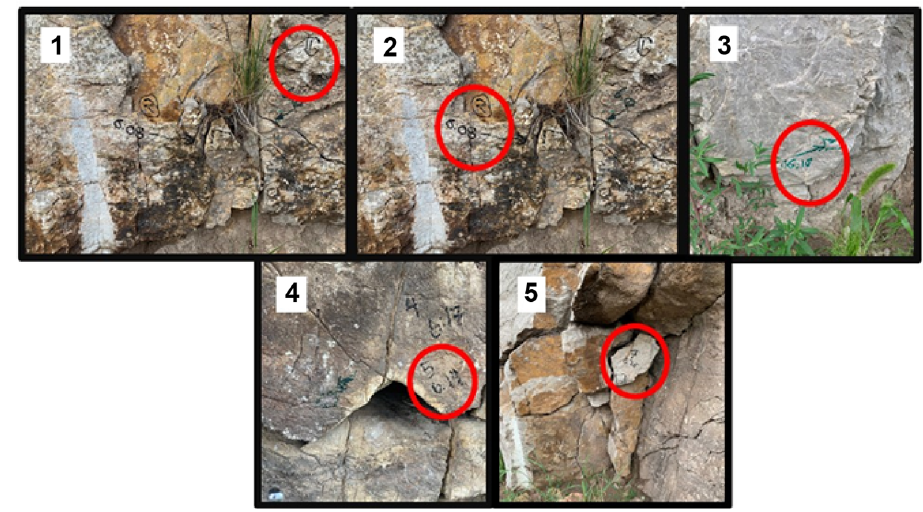
Figure 7. Test locations.